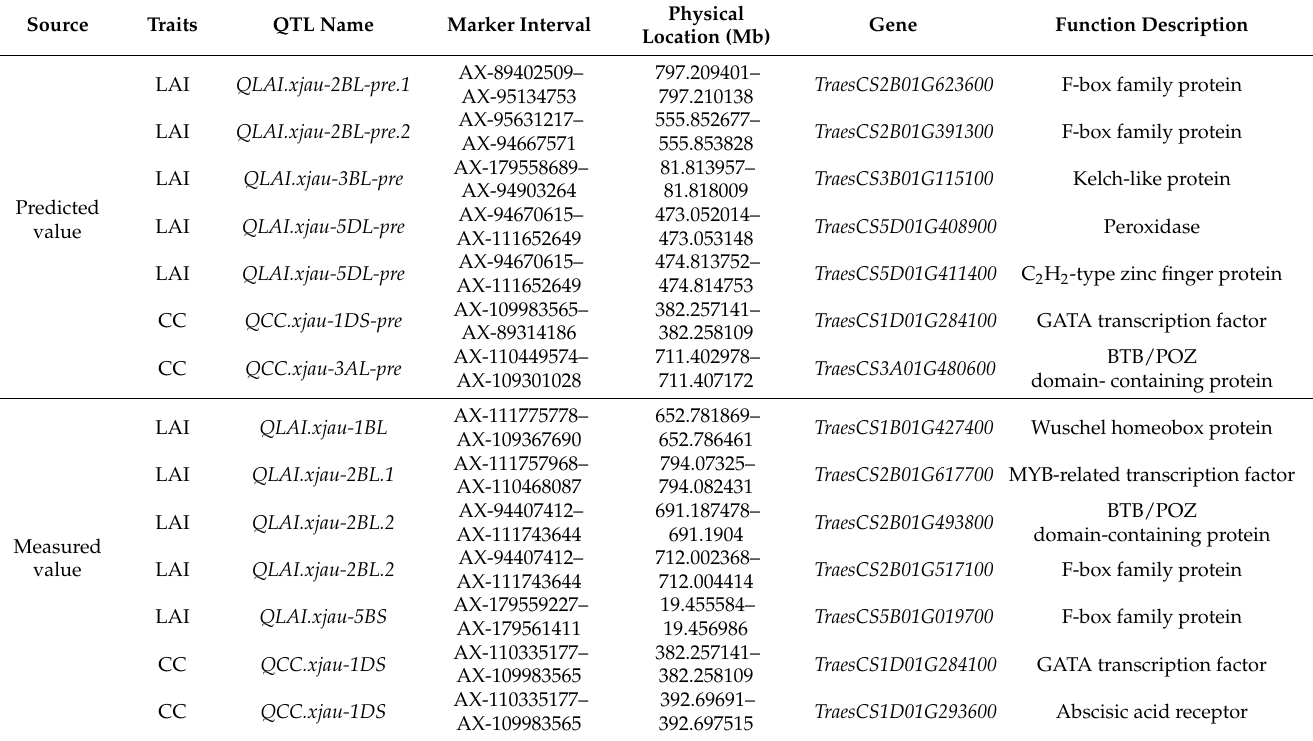
Table 7. The candidate genes for QTLs mapped with predicted and measured values of LAI and